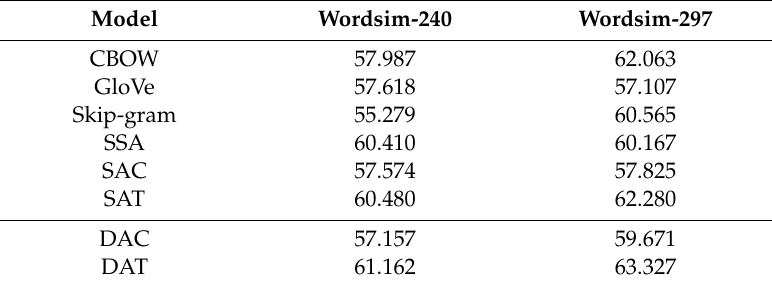
Table 3. Evaluation results of word similarity tasks.